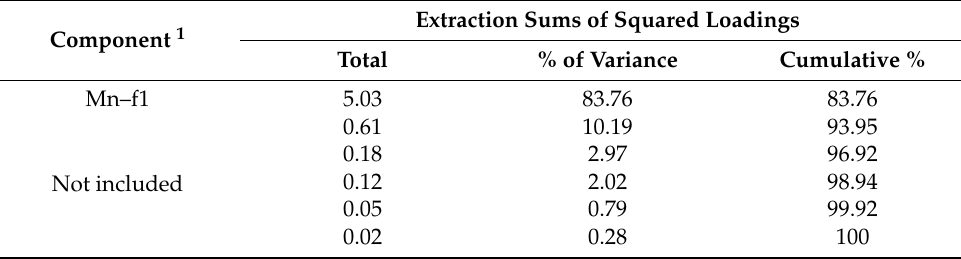
Table 2. Results of the principal component analysis of the element ratios of core